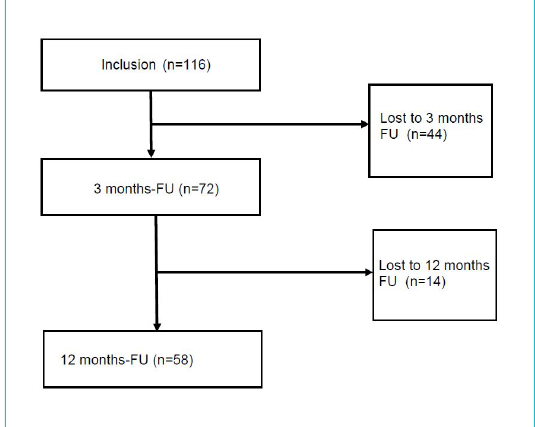
Figure 1: Flowchart of the prospective gout cohort at the Universi- ty Hospital Basel.